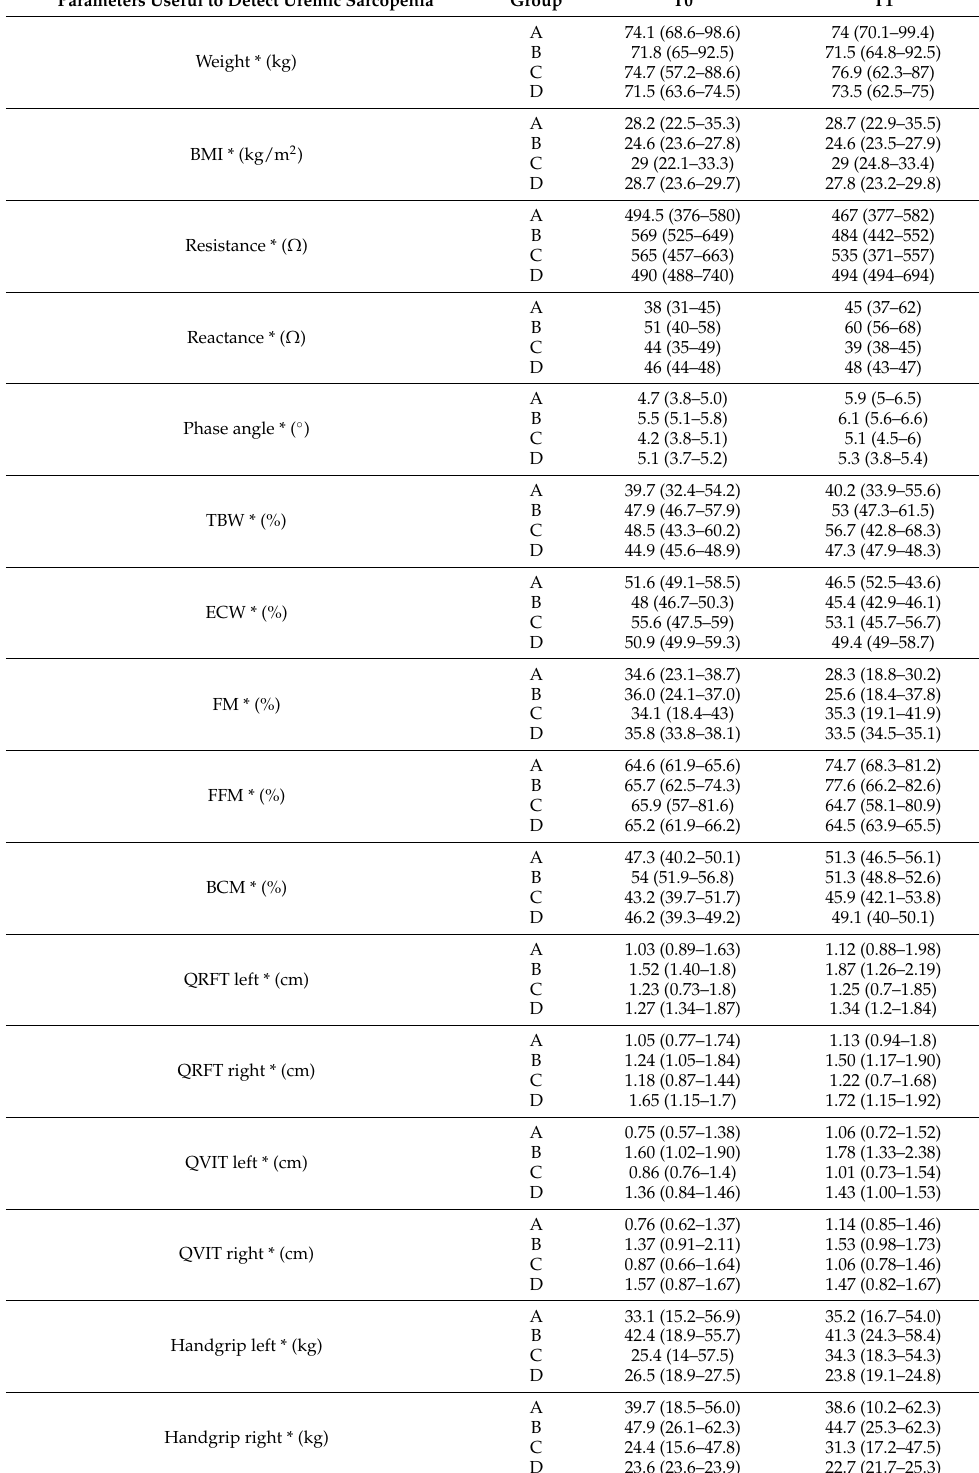
Table 6. Evaluation of body composition assessment, ultrasound. * This parameter is represented as median (minimum-maximum). Abbreviations: BCM, body cell mass; BMI, body mass index; ECW, extracellular water; FFM, fat free mass; FM, fat mass; QRFT, quadriceps rectus femoris thickness; QVIT, quadriceps vastus intermedius thickness; TBW, total body water. Parameters Useful to Detect Uremic